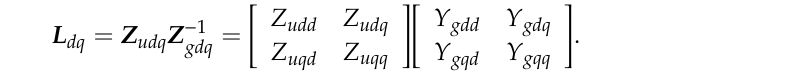
Table 2. The controller parameters of RSC and GSC. Controller Parameters